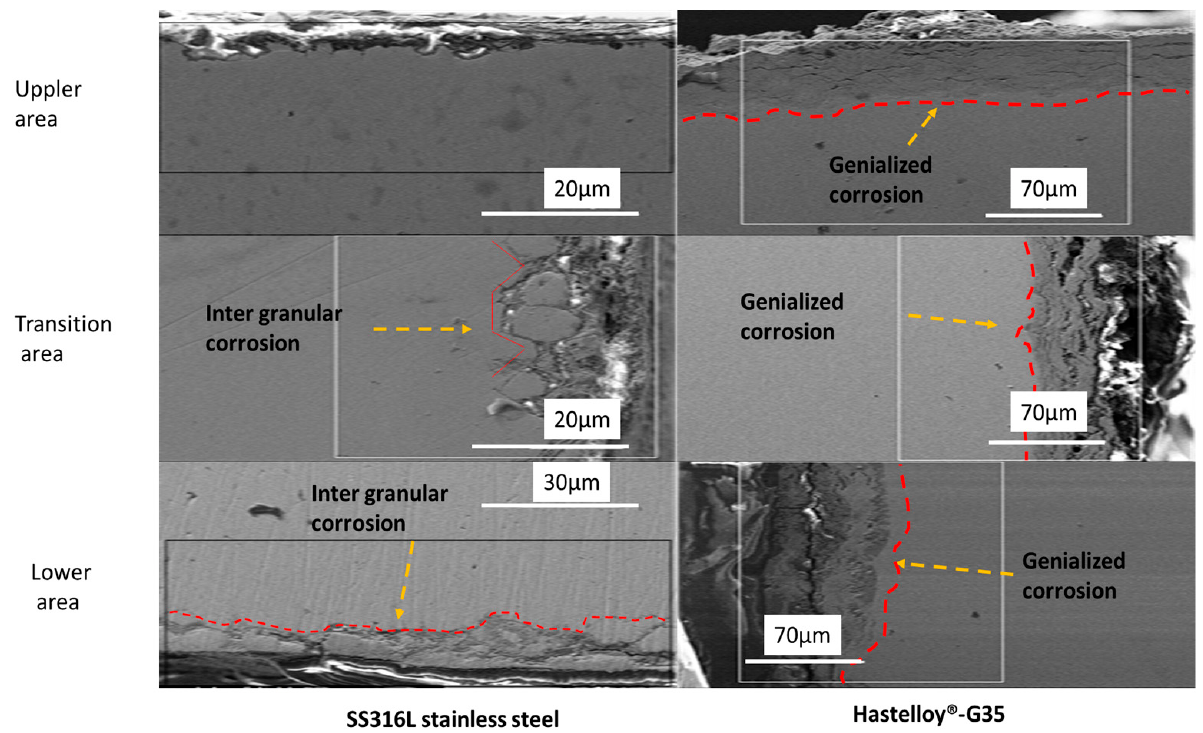
Figure 11. Cross sections of SS316L stainless steel and Hastelloy ® G35 ® . The SS316L sample shows intergranular corrosion. In the Hastelloy ® G35 ® sample, general corrosion can be seen. EDX mapping of the SS316L cross section shows inward diffusion of F, K and Na (see Figure 12) into the metal matrix. The thickness of the corrosion layer in the lower and transition areas was around 20 µ m, using the scale in Figure 12 for measurement. However, away from it, the corrosion will be shallow.